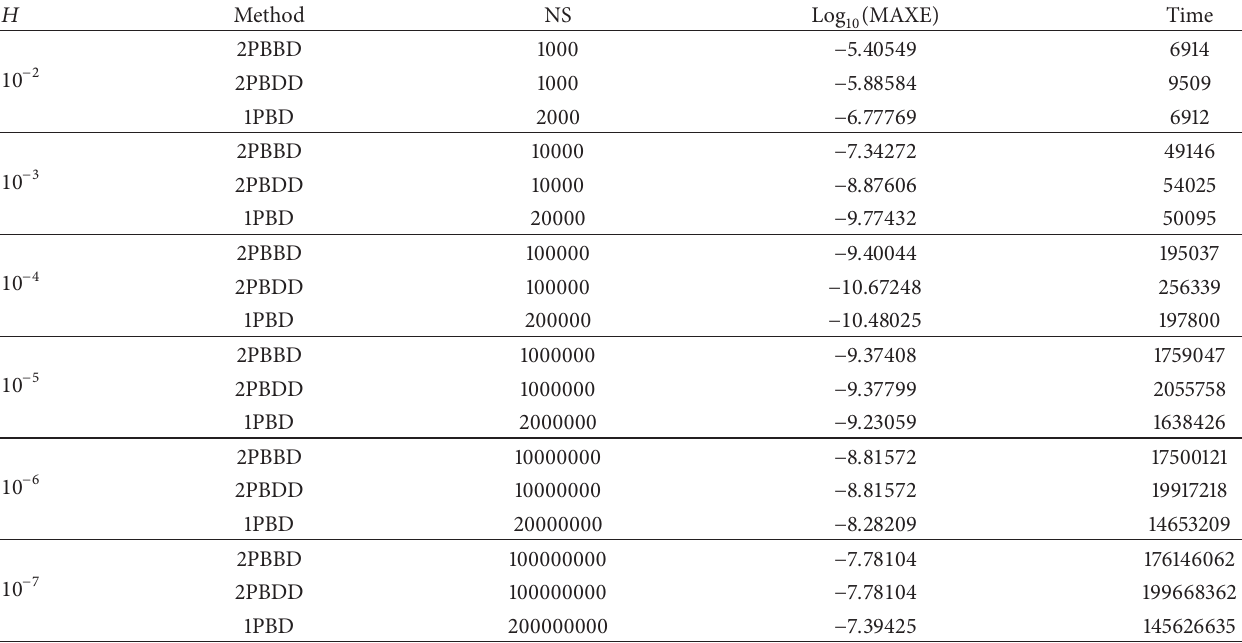
Table 4: Numerical result for Problem